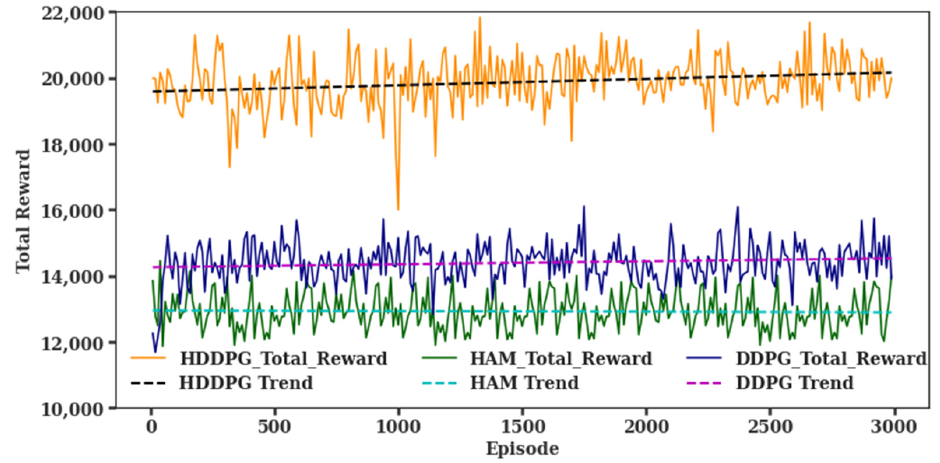
Figure 8. HDDPG demonstrated more than 35% of reward gain and more than 2 times of